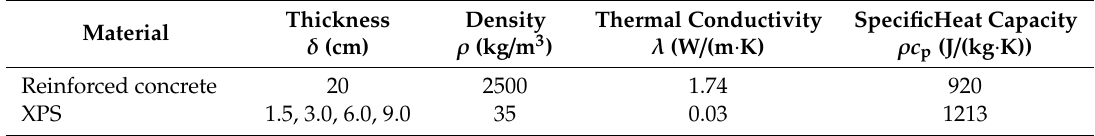
Table 1. Thermo-physical properties of external wall [17,18].